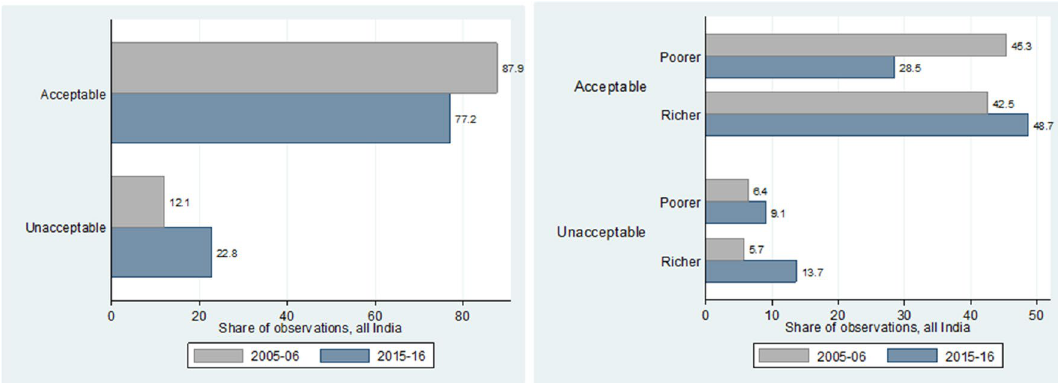
Figure 9. Variation in data quality over time for India overall and by wealth of